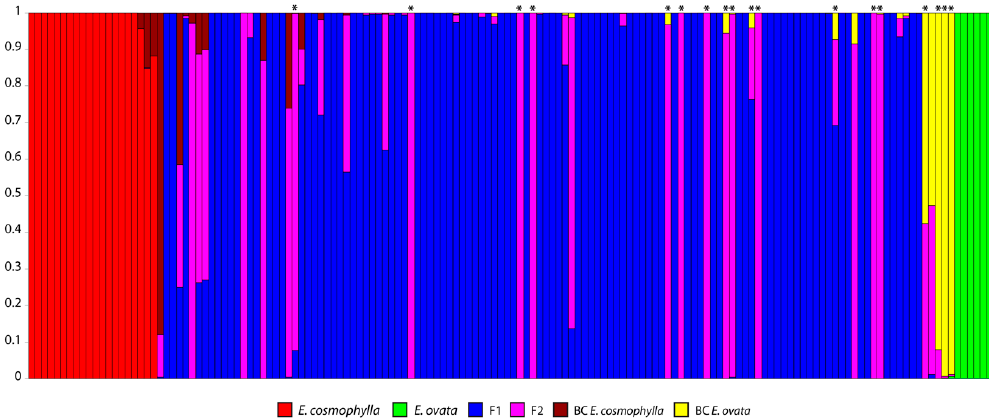
Figure 2. The proportion of individual assignment to 6 predefined genealogical classes for 151 Eucalyptus individuals, inferred using NEWHYBRIDS and 30 loci. Red and the green clusters correspond to “pure” E. cosmophylla and E. ovata, respectively, while E. paludicola is represented by a range of hybrid classes. The asterisks ( * ) correspond to E. paludicola individuals sampled from revegetation sites. BC in the figure stands for “back cross”.